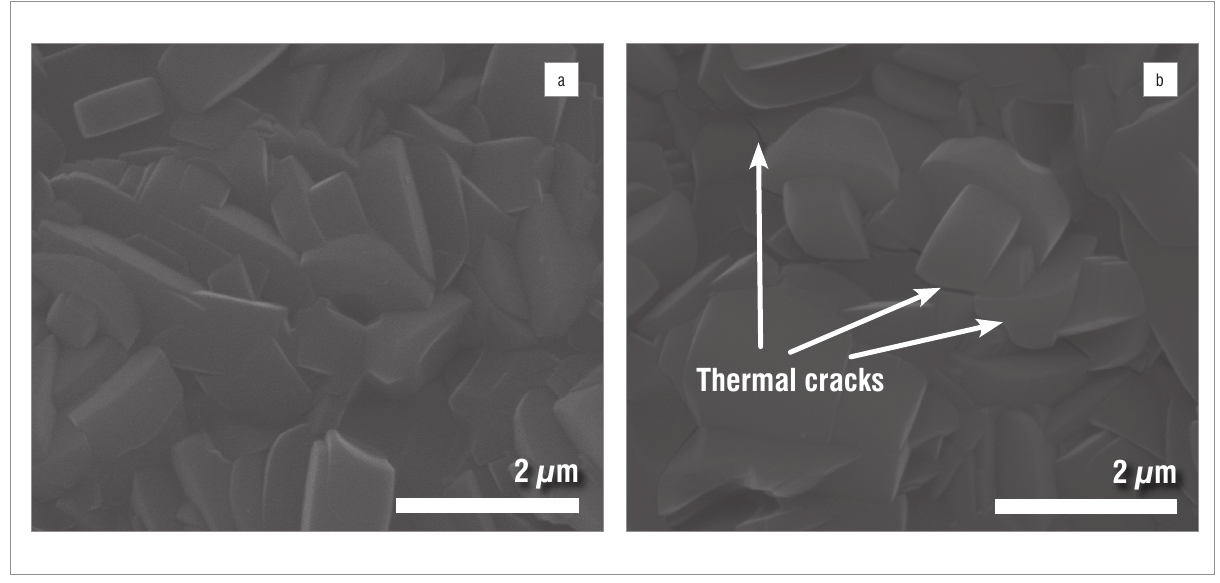
Figure 6: Scanning electron micrographs of the zeolite membrane (a) before and (b) after calcination. Cracks formed during template removal are shown in (b).